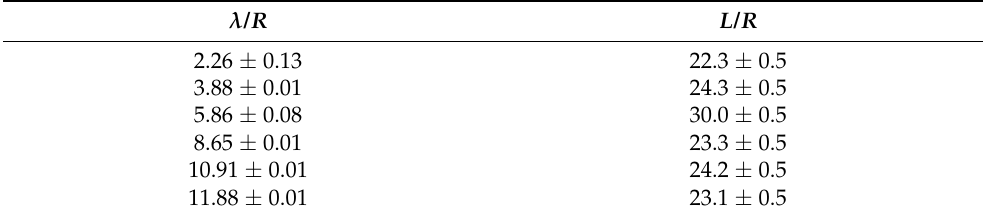
The helix parameters used in the experiments are listed Table 3: Table 3. Wavelengths and lengths of